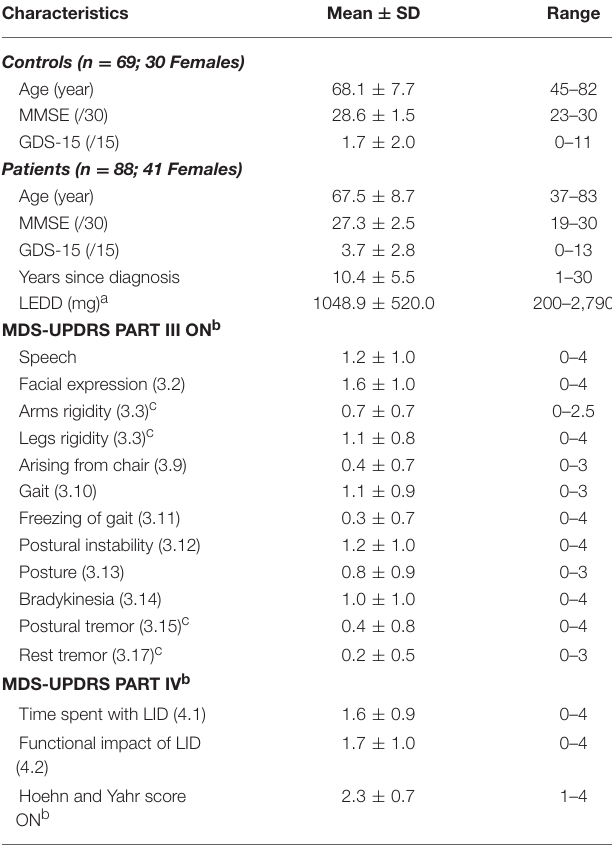
a Missing data for 9 participants. b Higher score indicates worse functioning. c Score represent the mean of the left and right segments. GDS-15,15-itemGeriatricDepressionScale;MDS-UPDRS,MovementDisorderSociety- Unified Parkinson’s Disease Rating Scale; SD, Standard deviation, LEDD, Levodopa Equivalent Daily